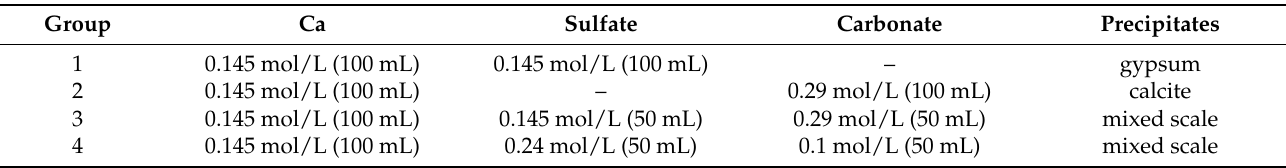
Table 1. Experimental contents in the study.